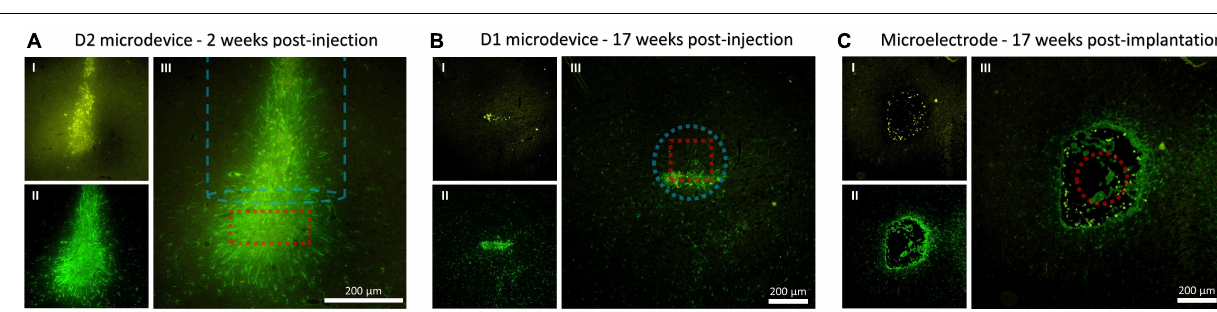
FIGURE 5 | Fluorescence microscopy images showing CD68 (microglia) and GFAP (astrocytes) immunoreactivity to the microdevice and microelectrode. (A) Coronal tissue slice at 2 weeks microdevice post-injection. (B) Axial tissue slice from rat #5 at 17 weeks microdevice post-injection. (C) Axial tissue slice from rat #5 at 17 weeks microelectrode post-implantation. Images I show CD68 (yellow), II show GFAP (green), and III merge I and II. The dashed red line shows the estimated location of the microdevice or microelectrode. The dashed blue line shows the injection track and outlines the dimensions of the injection